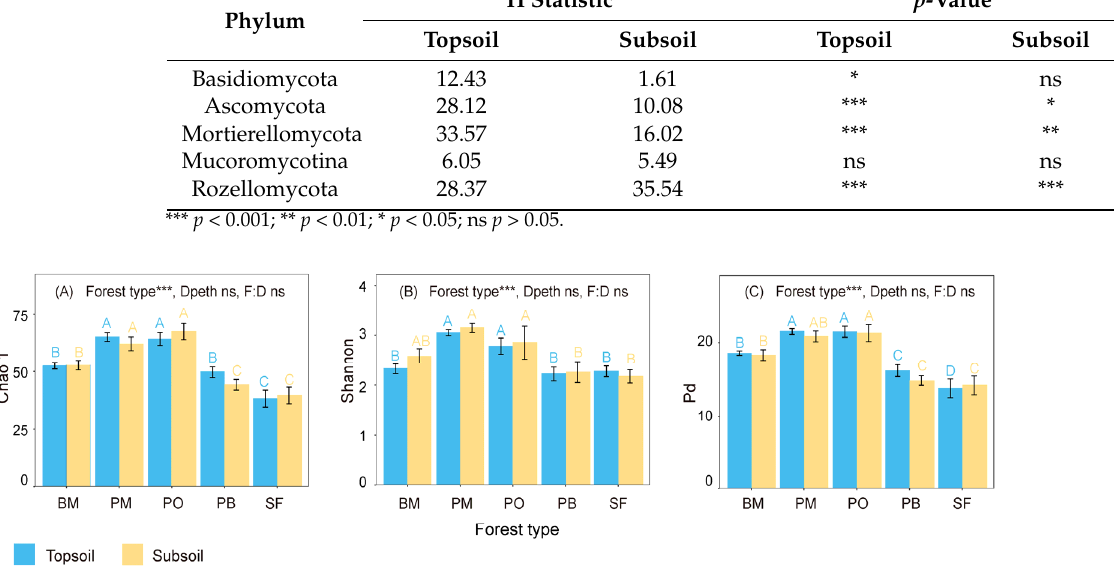
Figure 2. Relative abundance of main fungal phyla in different forest types. ( A ) topsoil; ( B ) subsoil. Broadleaf-oriented transformation, BM; P. massoniana mature plantation, PM; P. massoniana overmature plantation, PO; P. massoniana + local broadleaved trees, PB; secondary forests, SF.